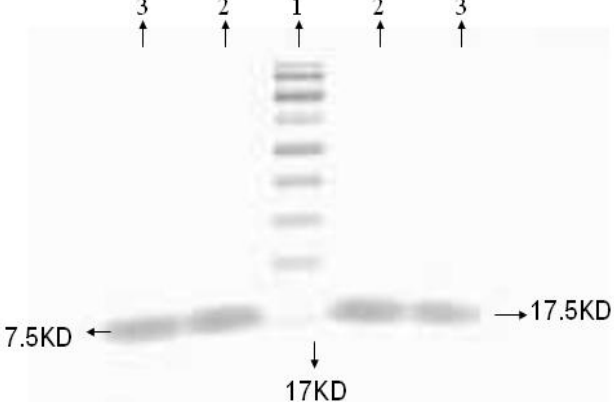
Figure 7. SDS-PAGE of TMV-CP Lane 1: Protein molecular weight marker; Lane 2: TMV-CP; Lane 3: